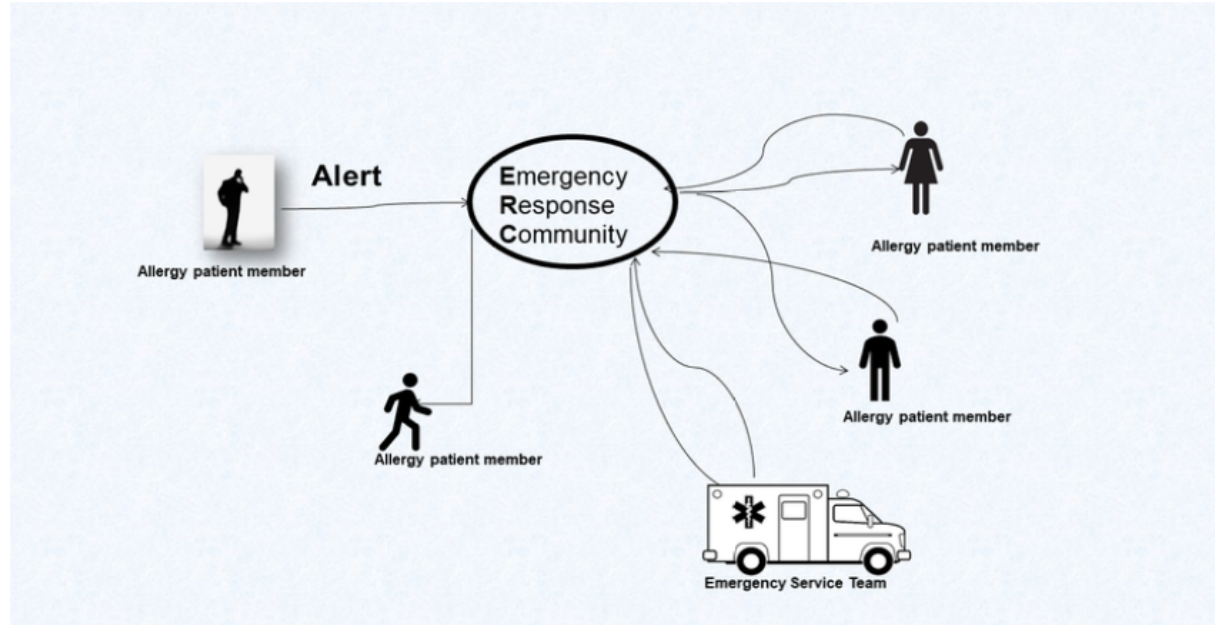
Figure 1. Proximity-based emergency response community during an anaphylactic